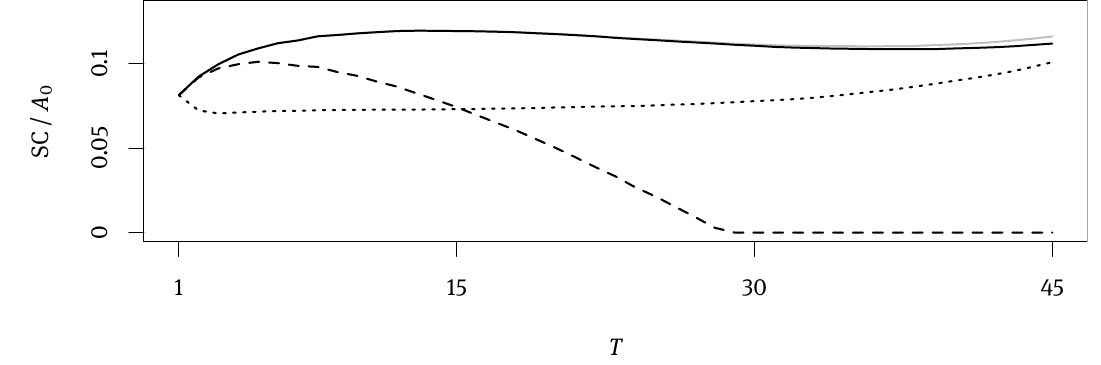
Figure 6: Solvency capital invested in zero-coupon longevity bonds (black curves) compared with those invested in zero- coupon bonds (grey curves) with the complete model in proportion of the initial value of the portfolio: solvency capital under SII (dotted line), at maturity (dashed line) and at ruin (solid